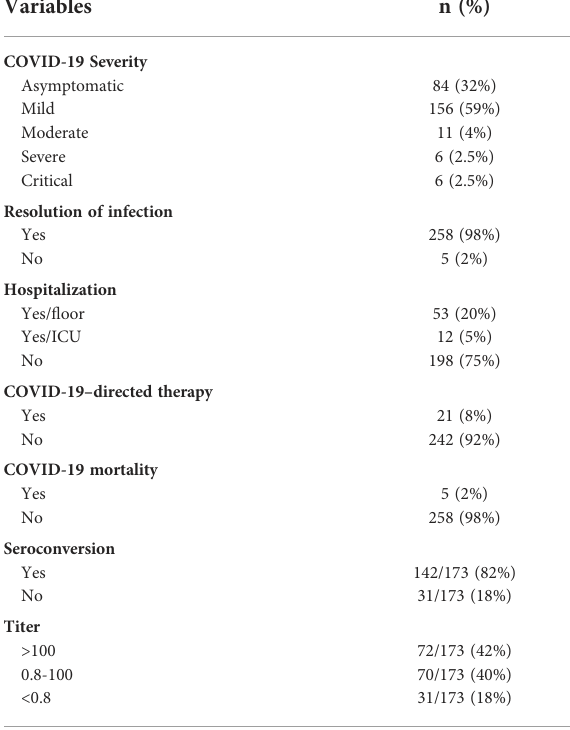
*n=263, patients COVID ‐ 19, coronavirus disease